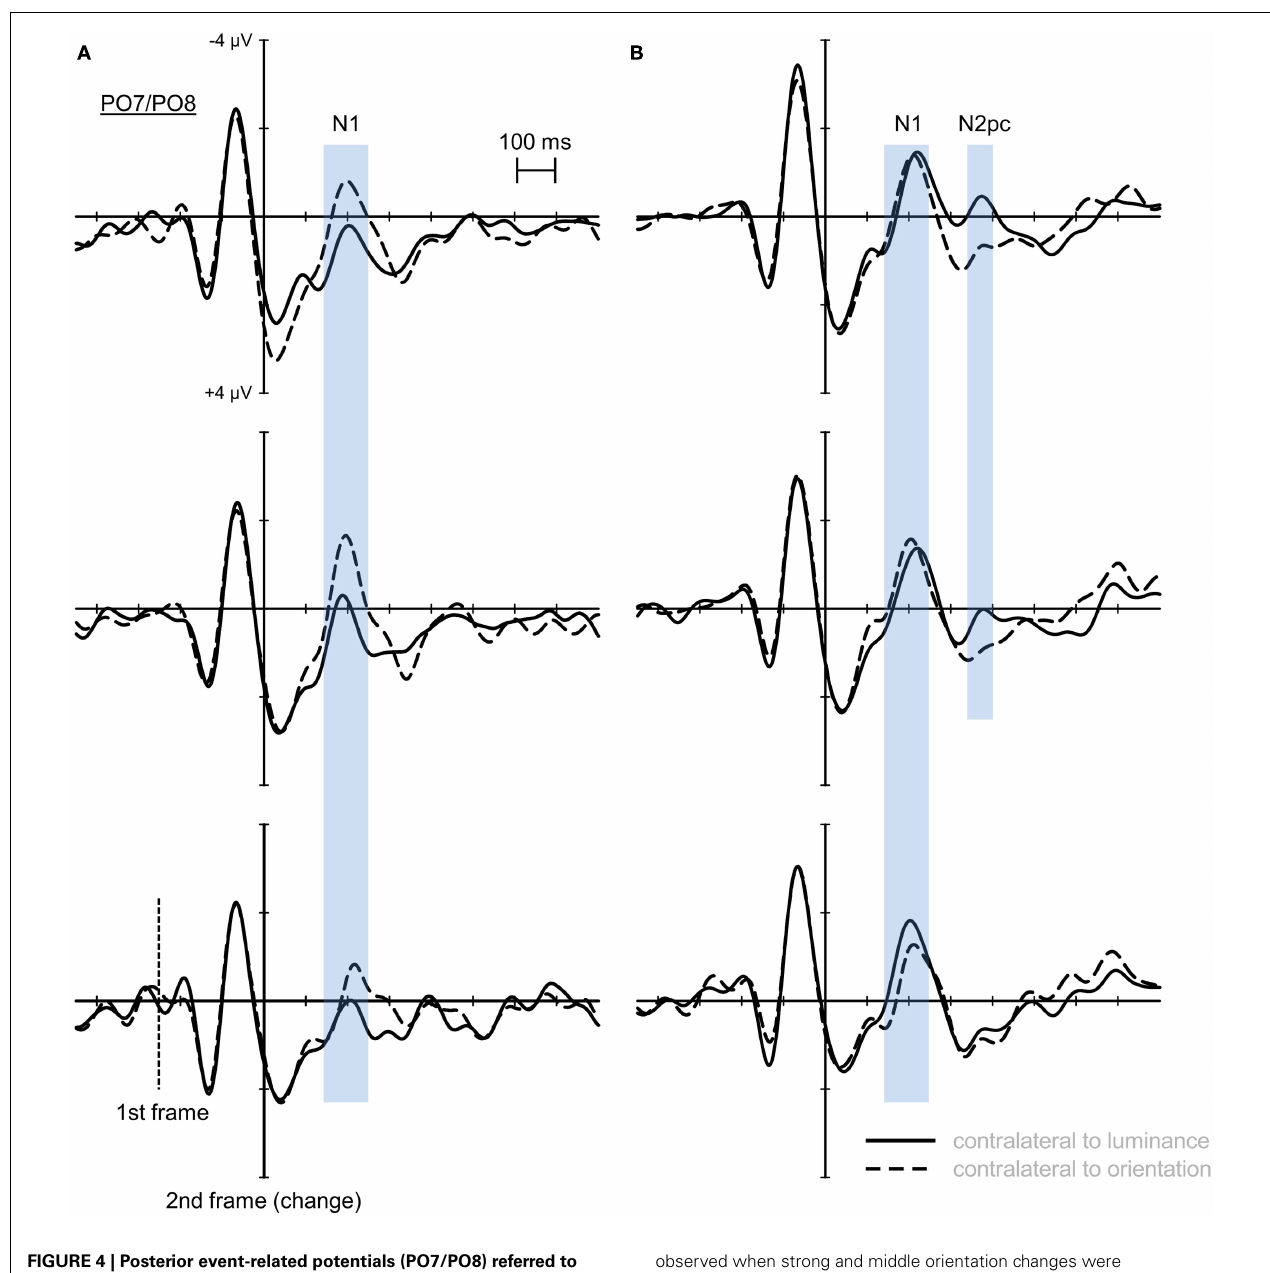
FIGURE 4 | Posterior event-related potentials (PO7/PO8) referred to averaged mastoids for erroneous (A) and correct change detection in the LOB condition (B). All figures are presented on the same scale. For erroneous change detection there was an N1 asymmetry with higher activation contralateral to the irrelevant motion for all salience levels. For correct change detection this asymmetry was modulated by the salience of the motion transient.While no asymmetry was